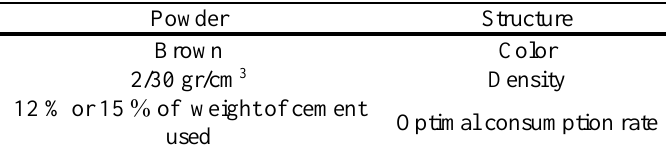
Table 4. Characteristics of rice paddy husk ash.